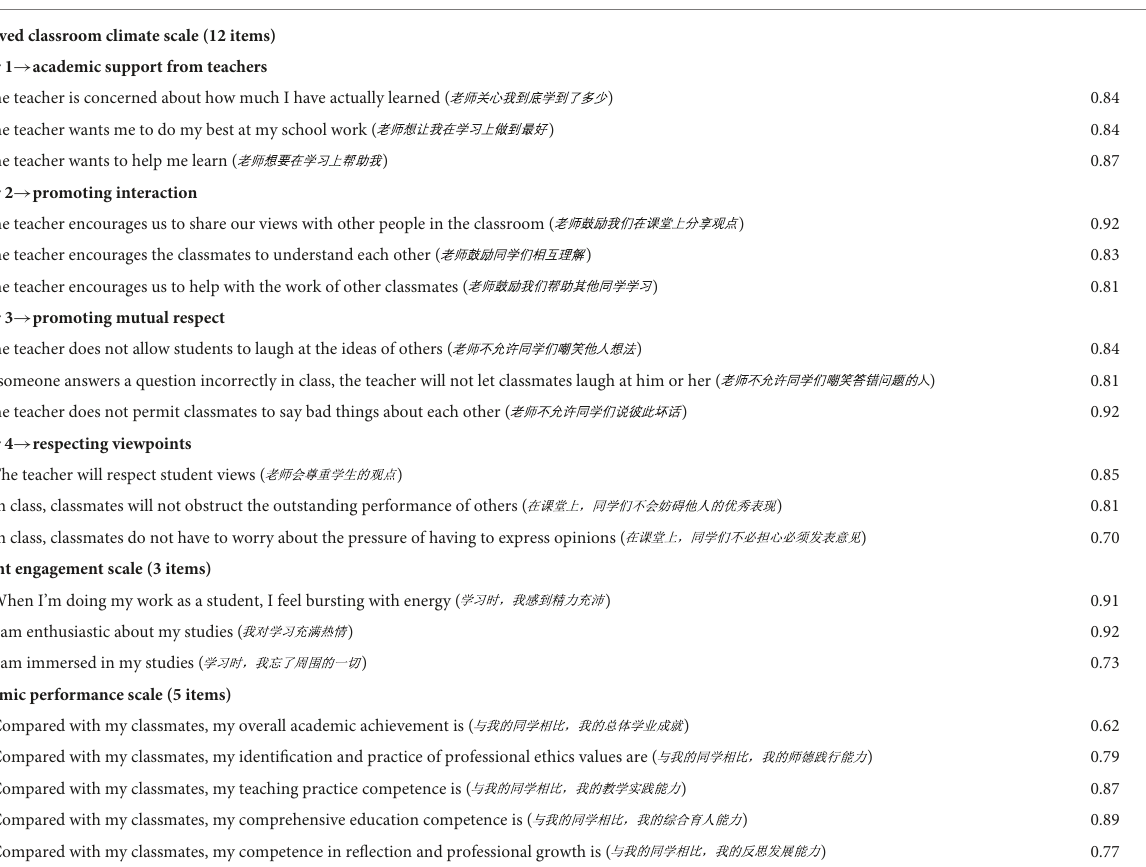
TABLE A1 Items and factor loadings of the perceived classroom climate scale, student engagement scale and academic performance